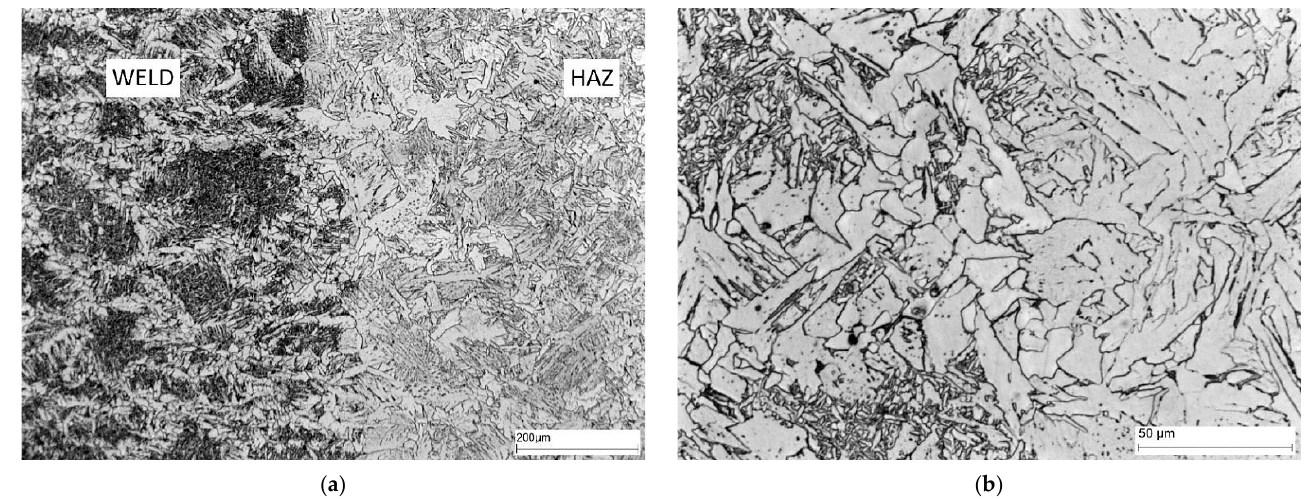
Figure 16. Microstructure of area C—fusion boundary: ( a ) 100× magnification, and ( b ) 500× magnification. Widmanstätten ferrite—white separations, hardening products, mainly bainite—dark separations.